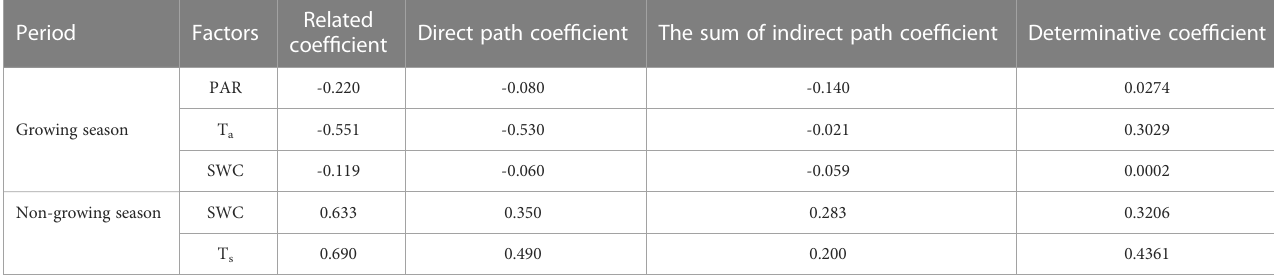
TABLE 2 Direct and indirect path coef fi cients of environmental factors on NEE (net ecosystem CO 2 exchange) seasonal variation.